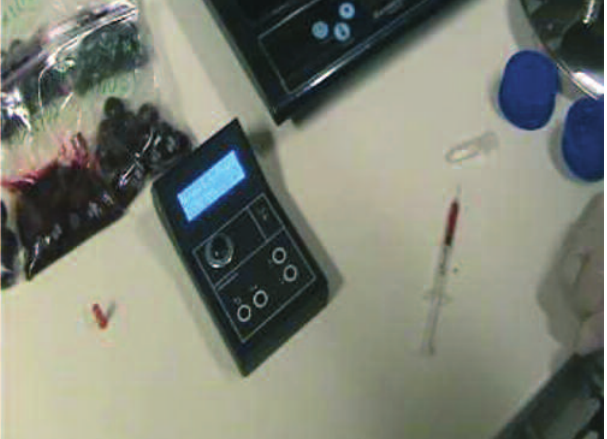
Figure 1. UVEX ML-1, the portable implement and its supplement for the quick measurement of the anthocyanin content of sour cherry fruits